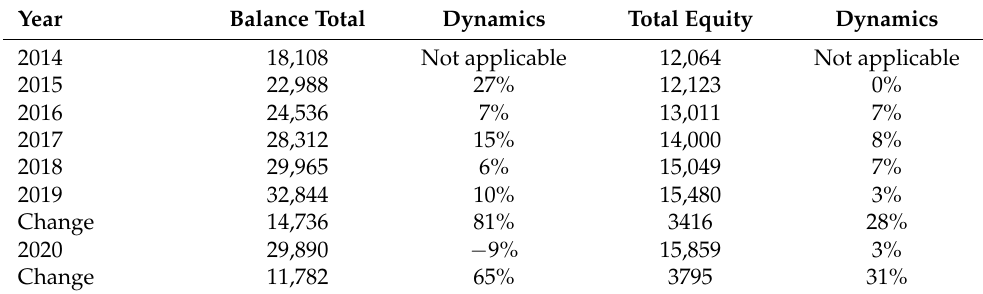
Table 9. Balance sheet total and equity of the ENEA capital group in the years 2014–2020 (in PLN